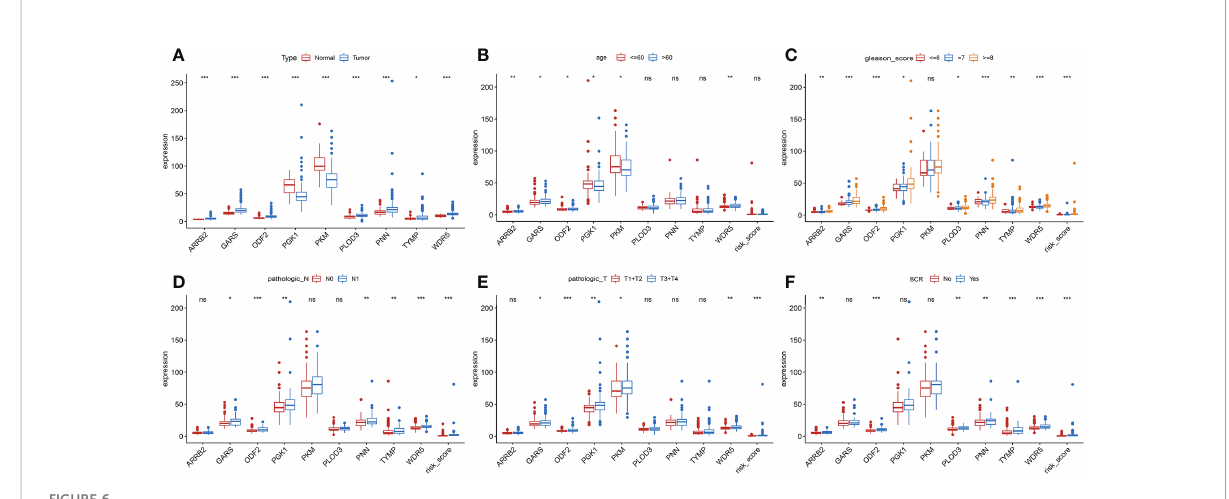
FIGURE 6 Clinical association analysis of this signature in TCGA. (A) Differential expression of 9 genes between normal and tumor tissues. (B-F) The association between the signature and clinical characteristics. (ns, p >= 0.05; *0.01 <= p < 0.05; **0.001 <= p < 0.01; ***p <0.001)